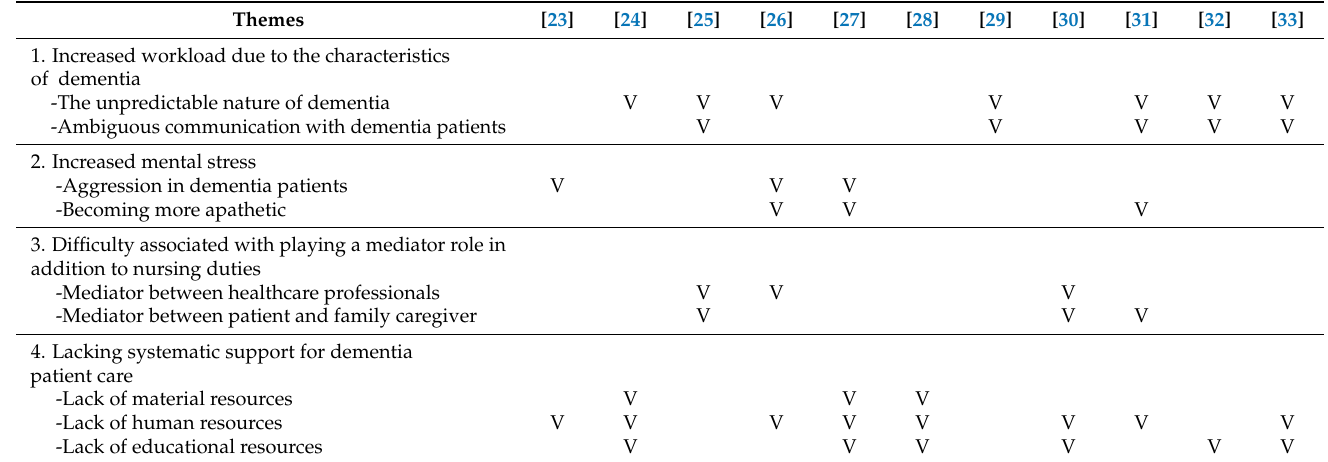
Table 2. Original study themes which contributed to the final meta-synthesis